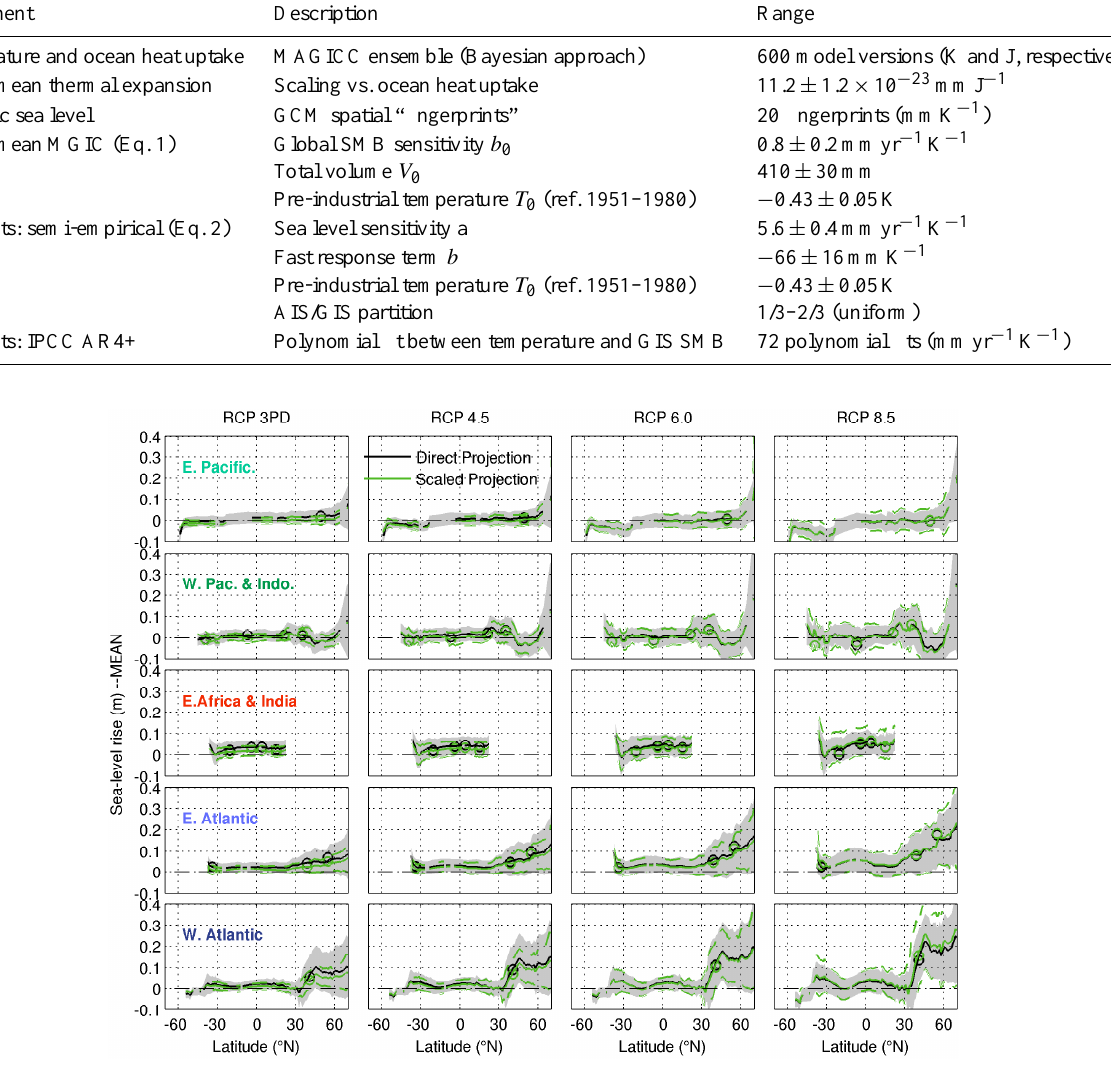
Fig. 3. Comparison between direct (black lines with grey shading) and scaled (green, solid lines with dashed envelope) dynamic sea level projections along coastlines (see explanations for the coastlines in the legend of Fig. 9), for the RCP scenarios 3PD, 4.5, 6.0 and 8.5 (from left to right panels). Solid lines indicate multi-model mean of the projections and the envelopes represent one standard deviation. The circles represent locations first introduced in Fig. 9. Note that the scaled projections are always based on the same regression pattern derived from all combined RCP scenarios. The projections are between 1980–1999 and 2090–2099